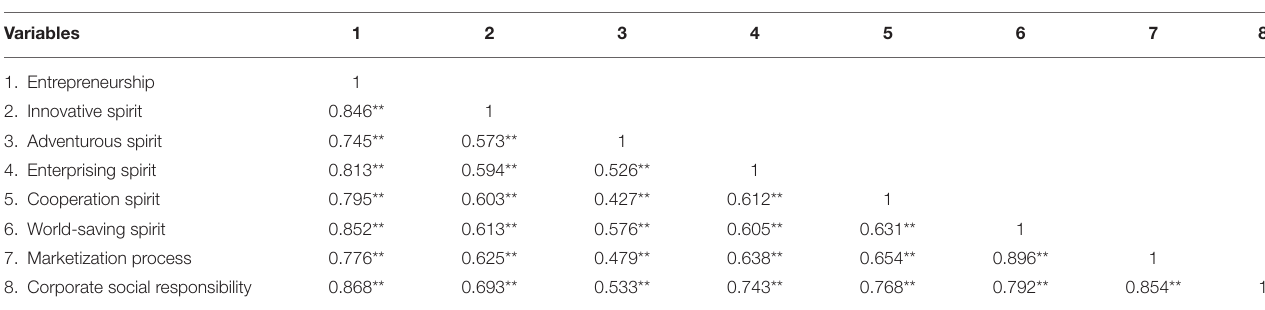
TABLE 1 | Results of key variables analysis and their dimensions.